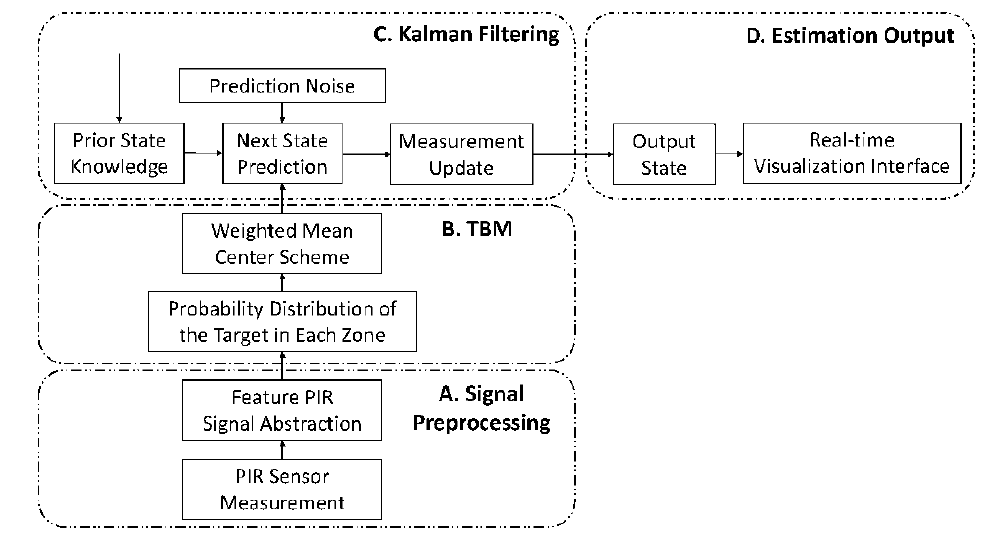
Figure 5. The flowchart of the proposed system with the refinement approaches.